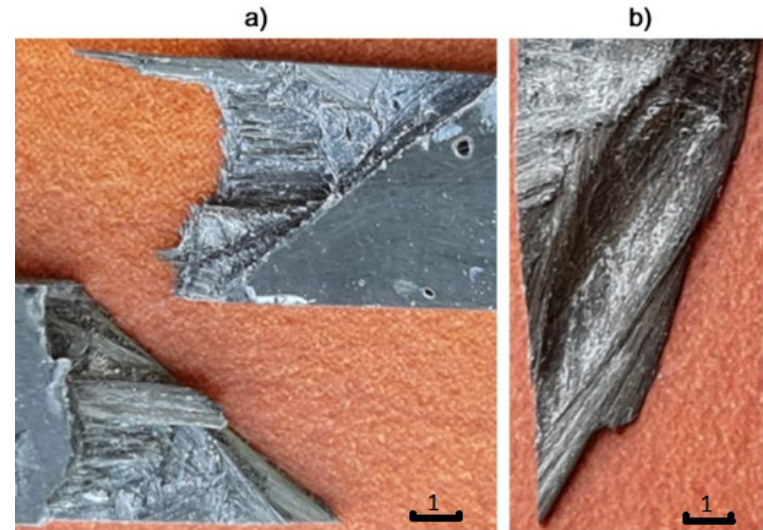
Polymers 2022 , 14 , x FOR PEER REVIEW 12 of 14